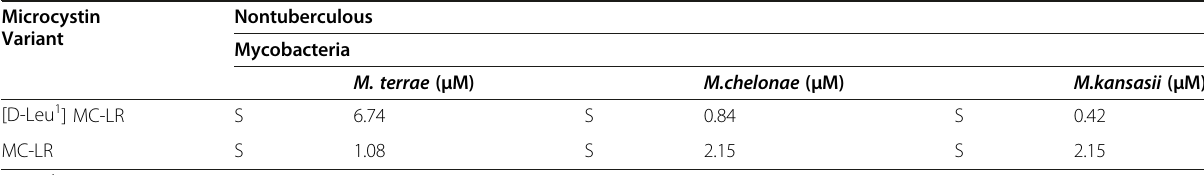
Table 3 Minimum inhibitory concentration (MIC) of the microcystin variant from extract of the M. aeruginosa RS9501 and MC-LR (obtained commercially) against M. tuberculosis strains